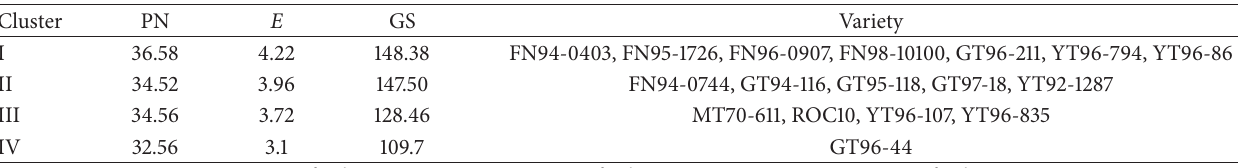
Table 3: Differences among different photosynthetic gas exchange parameters among 17 sugarcane varieties. Cluster